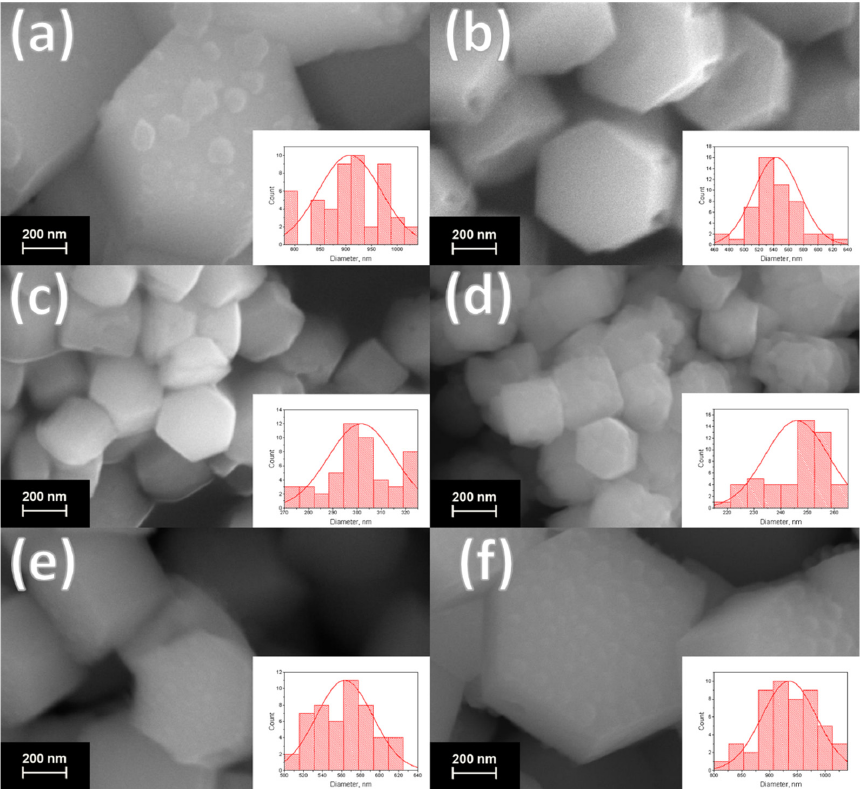
Figure 3. SEM images of the samples: ( a ) NaY 0.8 La 0.2 F 4 , ( b ) NaY 0.8 Pr 0.2 F 4 , ( c ) NaY 0.8 Sm 0.2 F 4 , ( d ) NaY 0.8 Gd 0.2 F 4 , ( e ) NaY 0.8 Ho 0.2 F 4 , ( f ) NaY 0.8 Lu 0.2 F 4 . Particle size distribution is shown in the insets. The average diameter of the particles is equal to 907 ± 61, 544 ± 31, 302 ± 14, 246 ± 12, 563 ± 30 and 935 ± 49 nm for the La 3+ , Pr 3+ , Sm 3+ , Gd 3+ , Ho 3+ and Lu 3+ , respectively. Additionally, one can notice that particle shape depends on the dopant atomic num- ber: the diameter-to-length ratio increases from La to Lu in both NaY 0.8 Ln 0.2 F 4 and NaY 0.6 Ln 0.4 F 4 series (Figures 3 and 4 in main text and in Figures S1 and S2 in